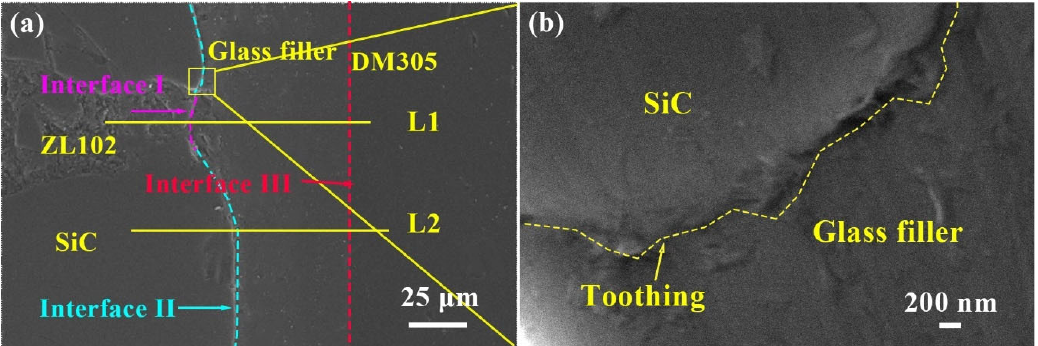
Figure 5. SEM images of the typical sealing joints at 540 °C for 30 min: ( a ) Overall morphology, ( b ) partially enlarged detail.